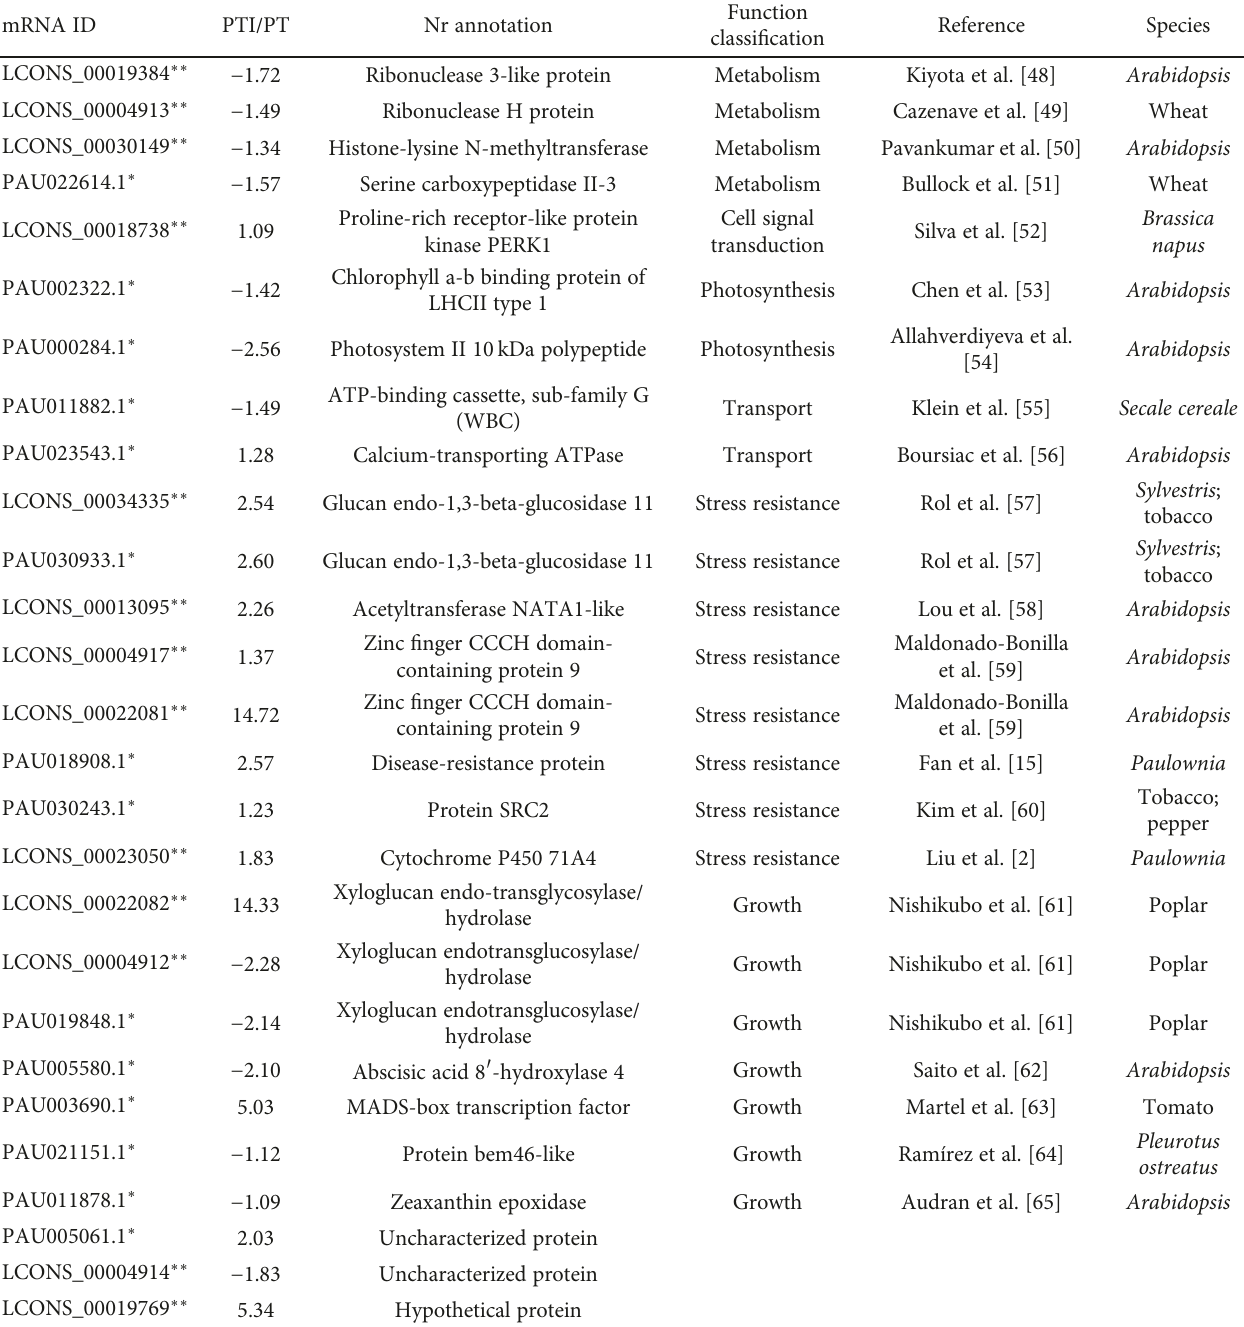
Table 3: List of identi fi ed and characterized PaWB related to proteins in other